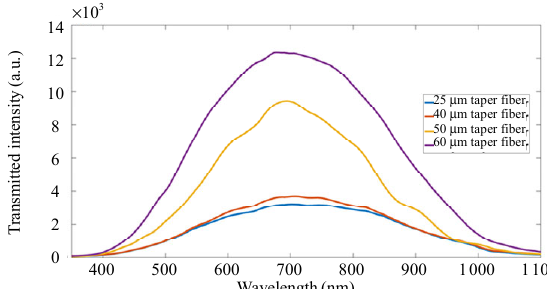
Fig. 6 Transmitted intensity spectra recorded through a different diameter of tapered fiber structures.